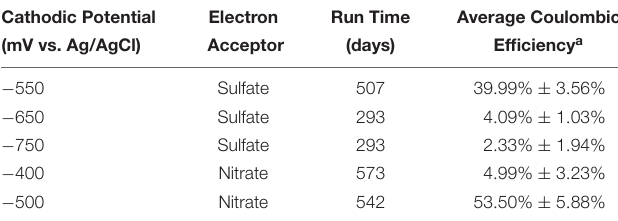
TABLE 1 | Summary of electrochemical bioreactor general run information. Cathodic Potential